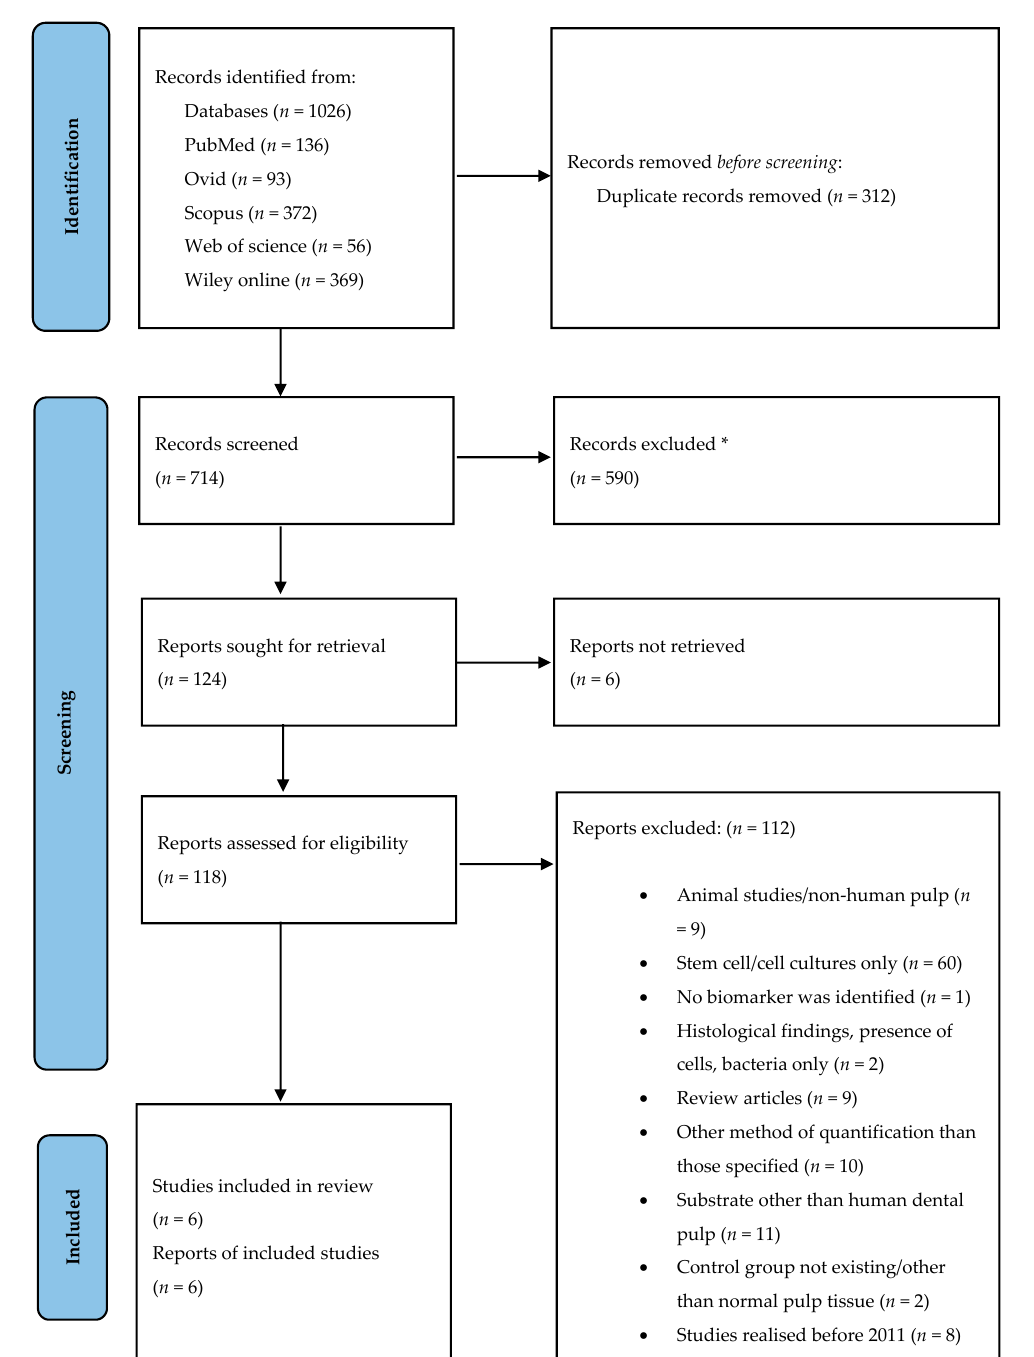
Figure 3. PRISMA outline. Identification of studies via databases. * All records were excluded manually; we did not use any automation tools. From: Page M.J., McKenzie J.E., Bossuyt P.M., Boutron I., Hoffmann T.C., Mulrow C.D., et al. The